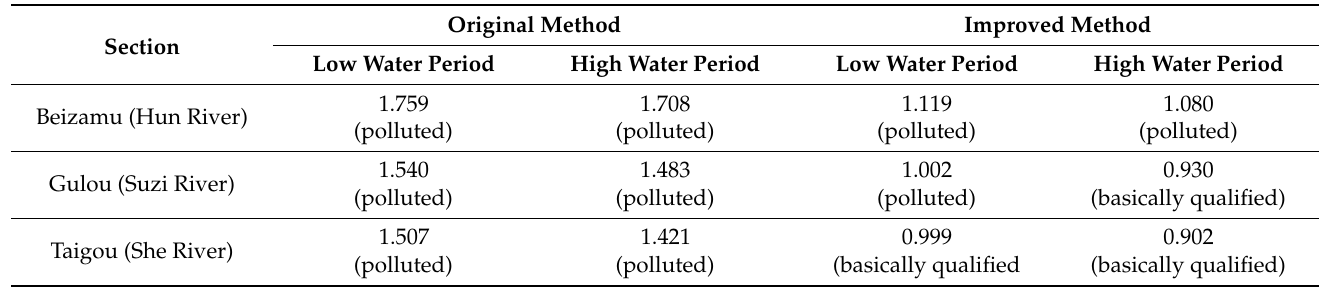
Table 7. The average P values of the three river sections from 2003 to